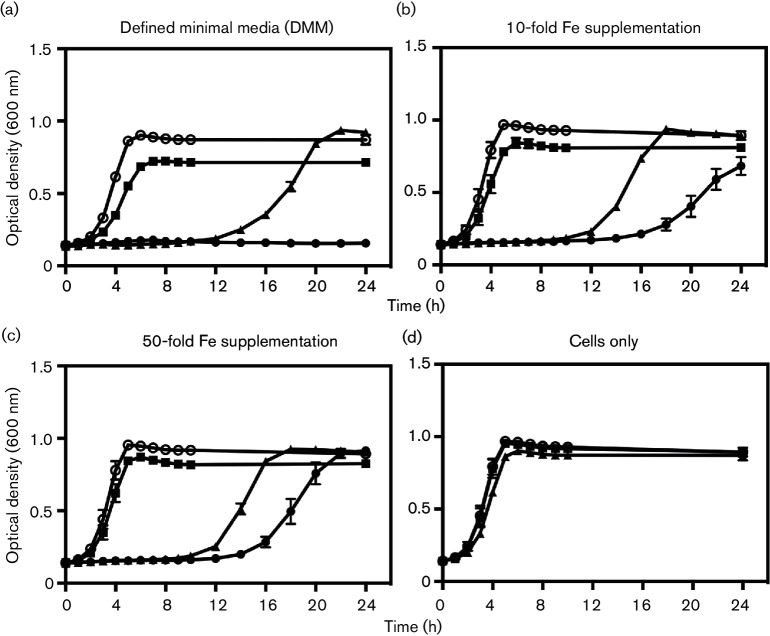
Iron supplementation reverses the combined toxicity of DOX and light-activated [Mn(CO)3(tpa-κ3N)]Br. Cells were grown in DMM (a), or media supplemented with 10-fold (b) or 50-fold (c) excesses of Fe(III). In (a), (b) and (c) are shown: cells in media alone (O), 200 µM activated PhotoCORM (■), 24 µg ml−1 DOX (▴) and activated PhotoCORM plus DOX (⚫). Controls with no additions (d) are: cells grown in DMM (▴), and 10-fold, and 50-fold (■) excesses of Fe(II). The bars are mean ±sem of three biological repeats.